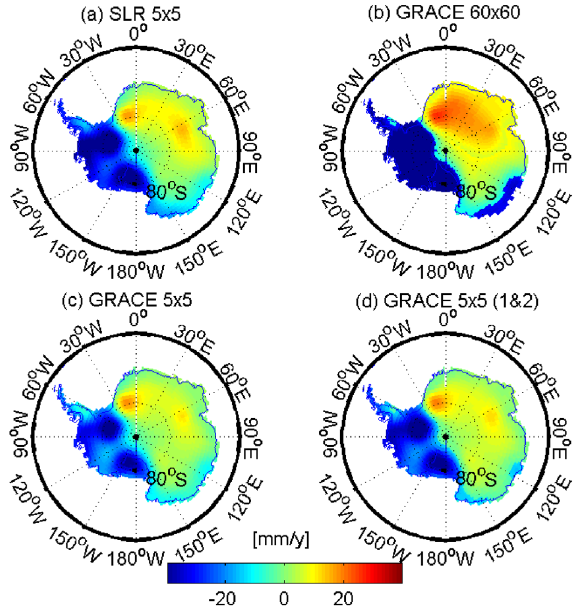
Figure 1. The trends of ice-sheet mass variations over Antarctica from (a) SLR 5×5, (b) GRACE 60×60, (c) GRACE 5×5, and (d) GRACE 5×5 (1&2) with replacement of degree 1 and C equivalent water thickness change. The GIA effect is